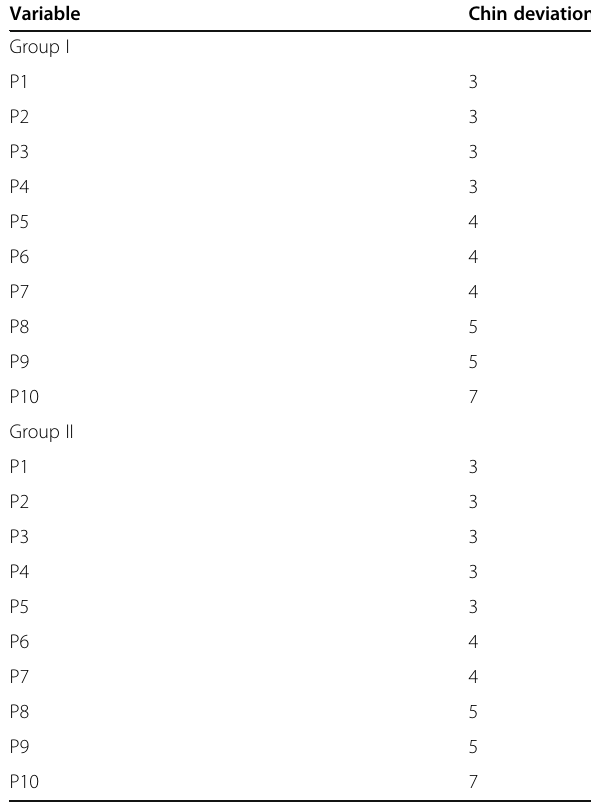
performed. Group I consisted of 10 patients who under- went BSSRO alone, and Group II consisted of 10 pa- tients who underwent both BSSRO and DSO. Table 1 shows the amount of chin deviation of the patient before surgery. Table 1 Each patient ’ s chin deviation. Group I and Group II Variable Chin